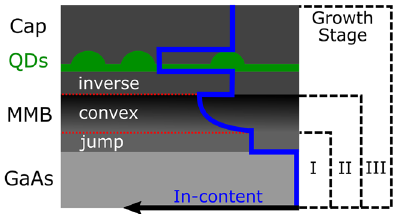
Figure 1: Schematic structure of InAs QDs inside an InGaAs-matrix lattice matched to an MMB grown on a GaAs substrate. The varying indium content throughout the structure is illustrated in blue. stages I, II and